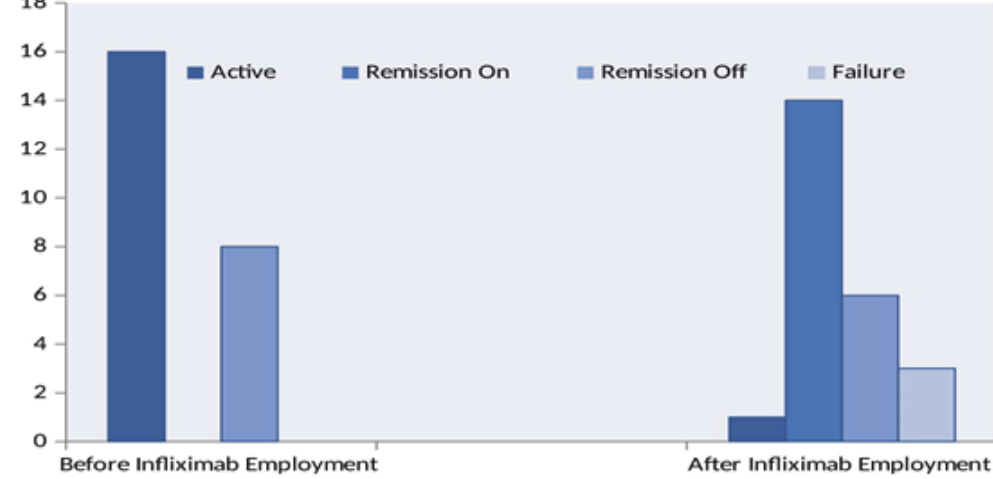
Figure 2. The number of patients with active disease, remission on infliximab Infliximab, remission off infliximab therapy before starting the treatment and at the end of the follow-up